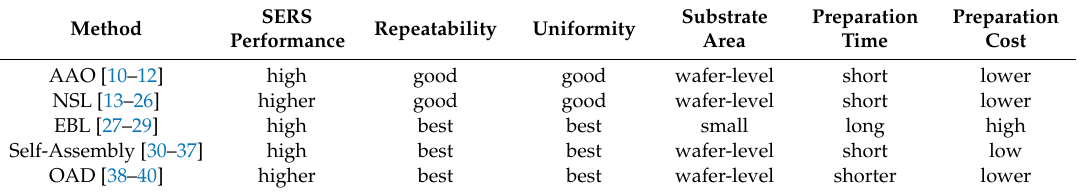
Table 1. Typical methods to fabricate solid-state surface-enhanced Raman scattering (SERS)